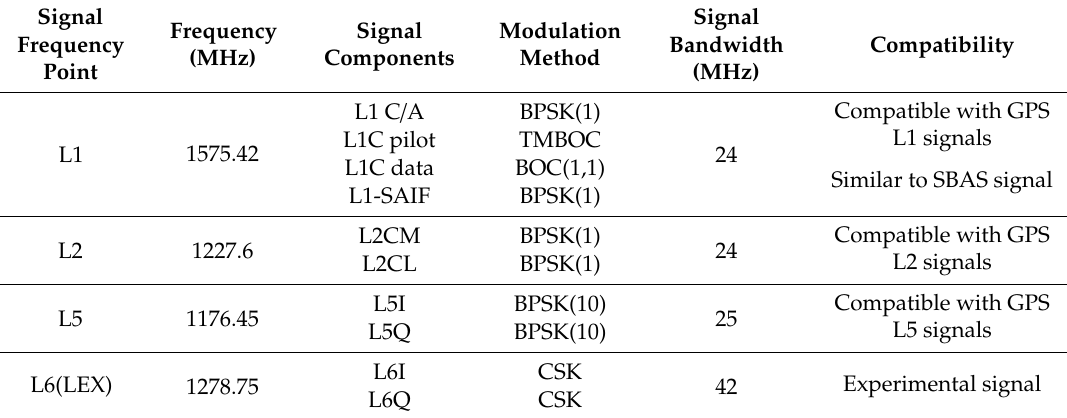
Table 1. QZSS system broadcast signals and modulation methods.